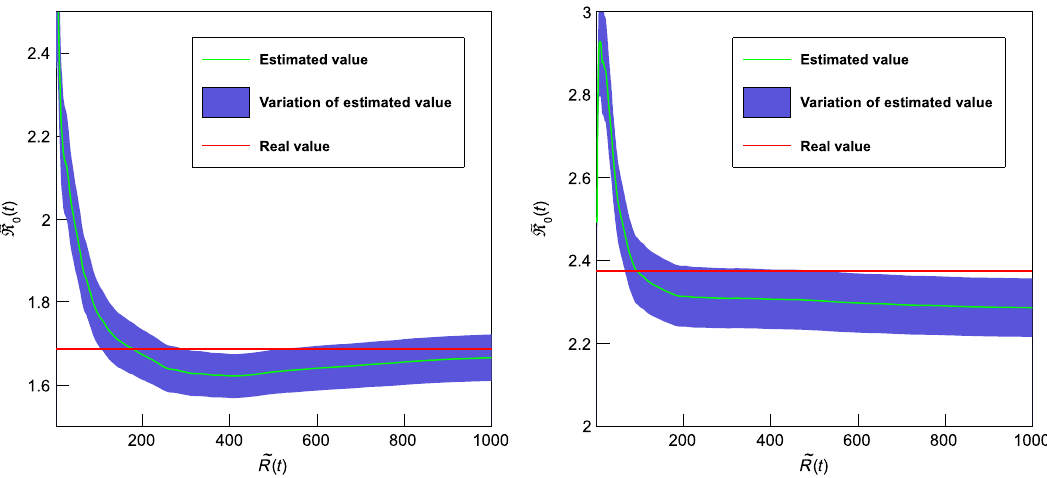
FIG. 12. The estimated basic reproduction number for the binomial (left panel: z 1 ¼ 5 , (cid:1) i ¼ 0 : 127 71 , and (cid:1) r ¼ 0 : 25 ) and exponential (right panel: (cid:5) ¼ 4 ) networks in terms of the number of removed individuals. The green curve and red line correspond to the estimated (with the correct excess degree) and real value of the basic reproduction number. The blue area shows the variation of the estimated value with respect to change of the excess